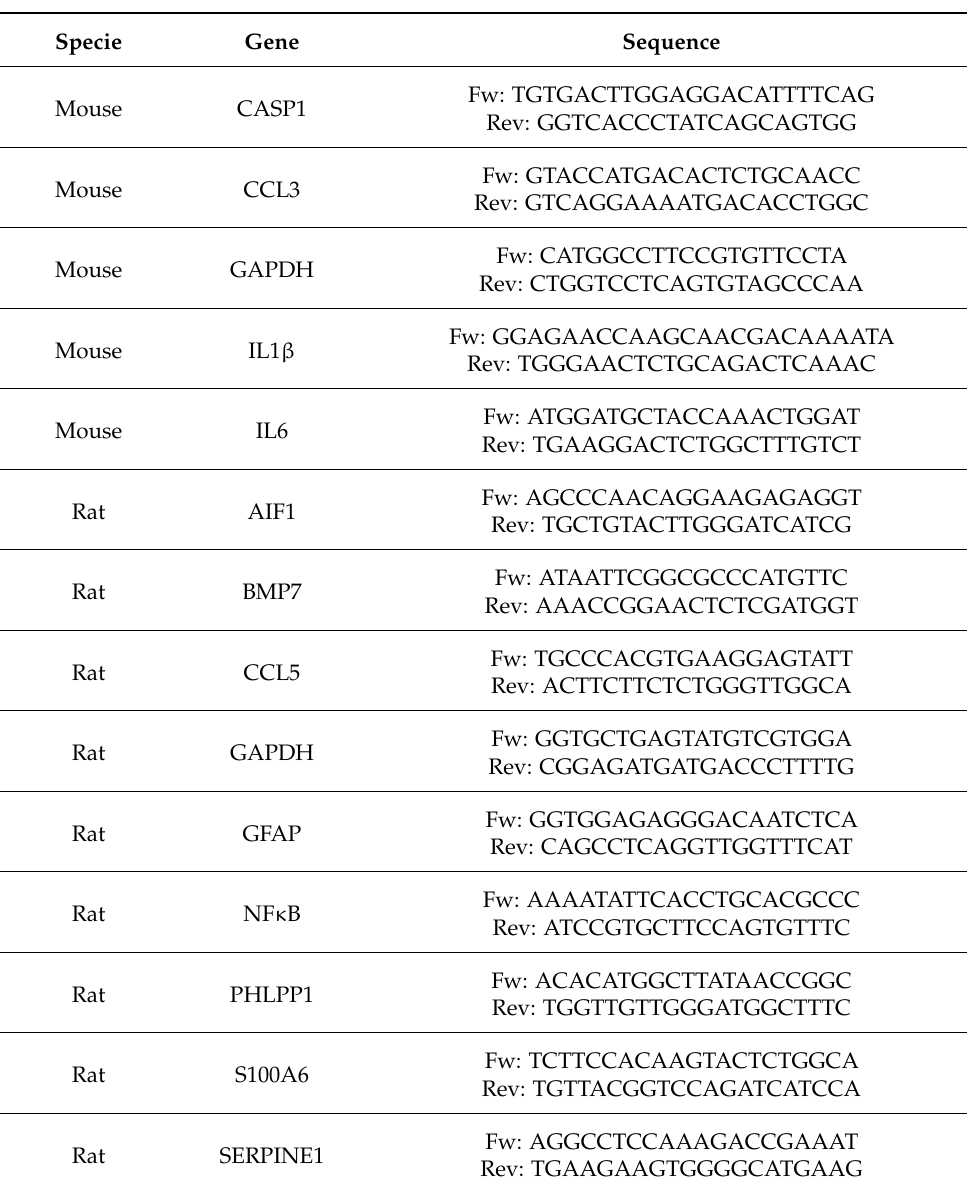
Table 1. Primers for